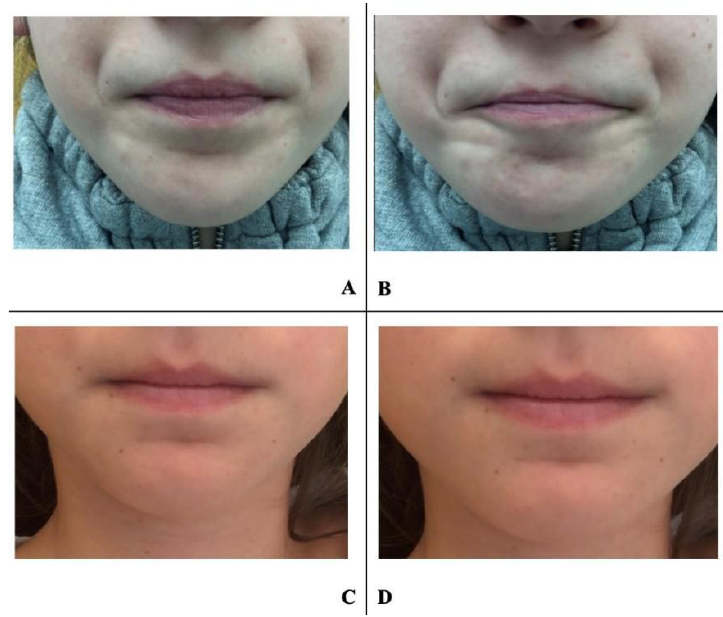
Figure 5. An 8-year-old patient. ( A – B ) before treatment; ( C – D ) after 6 months of treatment; ( A ) rest position, before treatment; ( B ) during swallowing, before treatment; ( C ) rest position, after treatment; ( D ) during swallowing, after treatment.